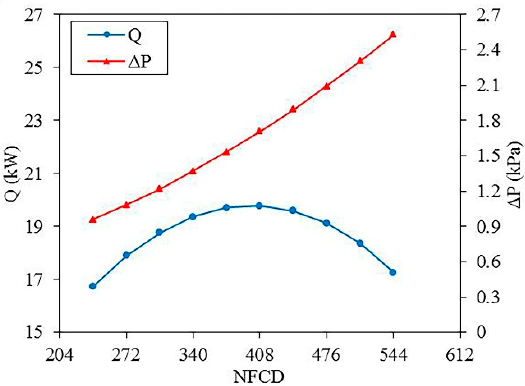
Figure 16. Q and Δ P separately versus number of fins in circumferential direction (NFCD).